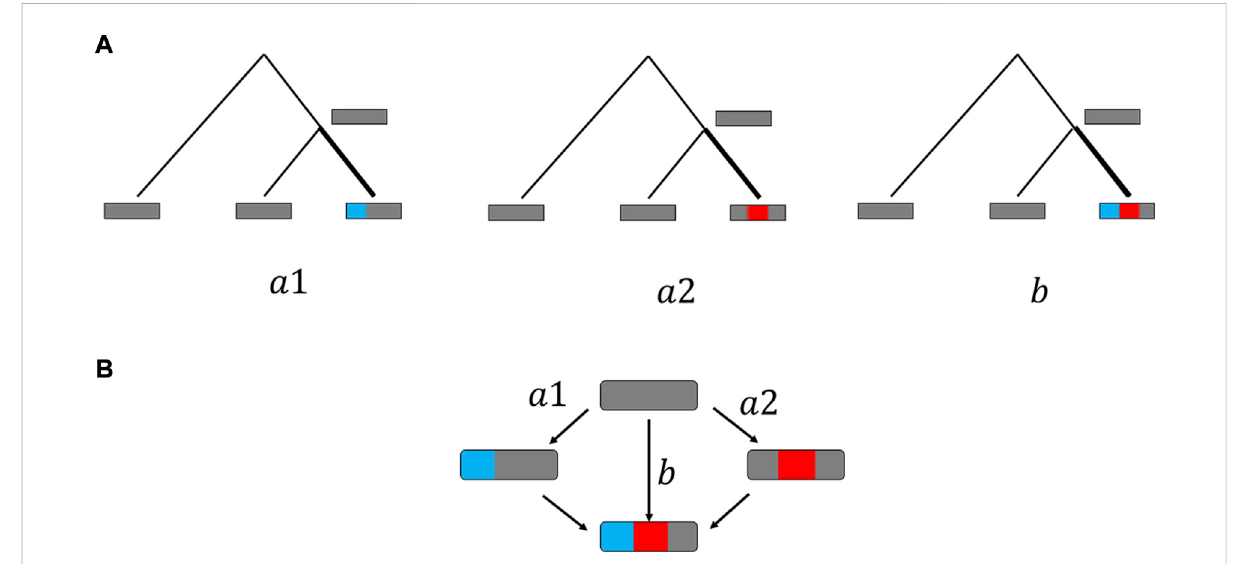
FIGURE 1 Conceptual scheme of double substitution analysis. (A) Single or double substitutions are inferred from the genomic data by construction of genomes triplets and relying on parsimony principle (see Material and Methods). (B) Point mutations are assumed to appear one at a time, such that observed double substitutions (B) occur through intermediate single substitutions states. For each double substitution, there are two possible single substitution pathways (a1, a2) . The double fraction DF is calculated as the ratio between the number of double substitutions (b) and the sum of relevant single (a1+a2) and double (b)